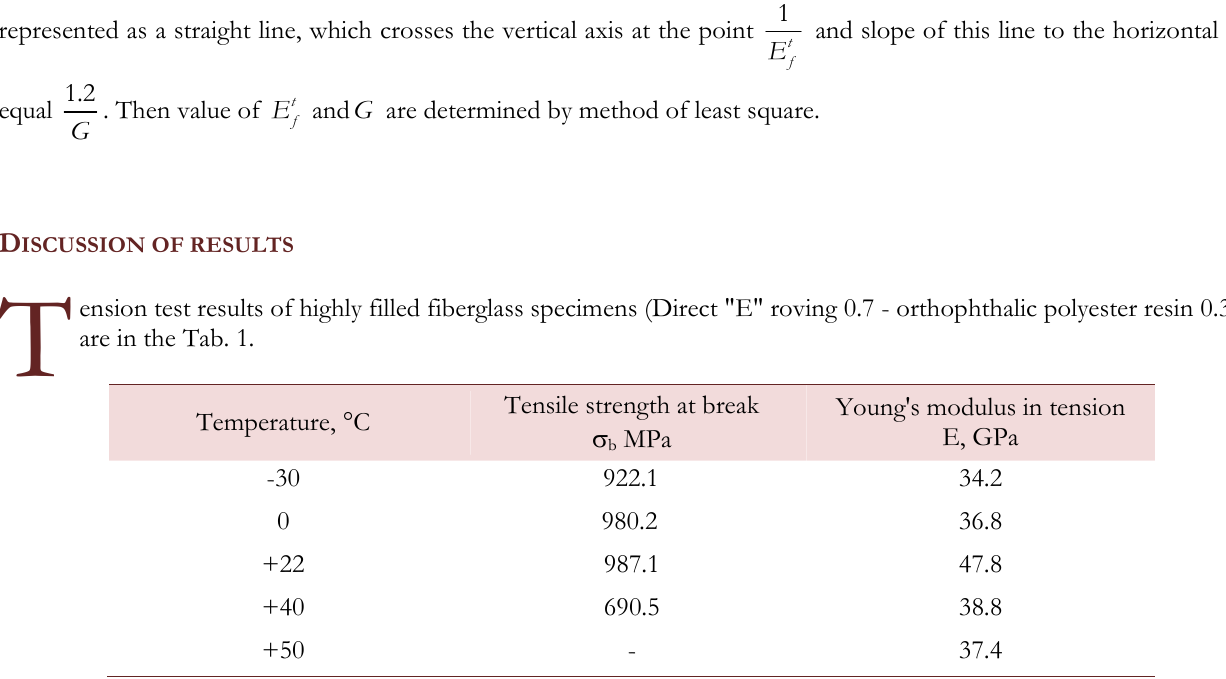
Table 1: Unidirectional fiberglass (Direct "E" roving 0.7 - orthophthalic polyester resin 0.3) properties at tension test [3].